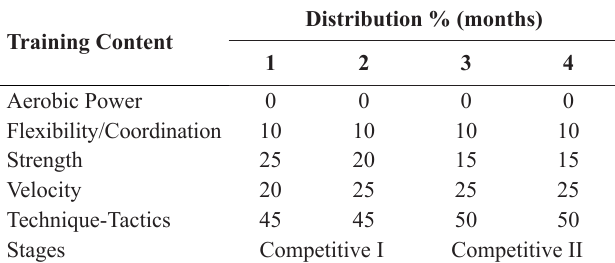
Table 3. Distribution of the training content among different capaci - ties and skills during the competitive stage I and